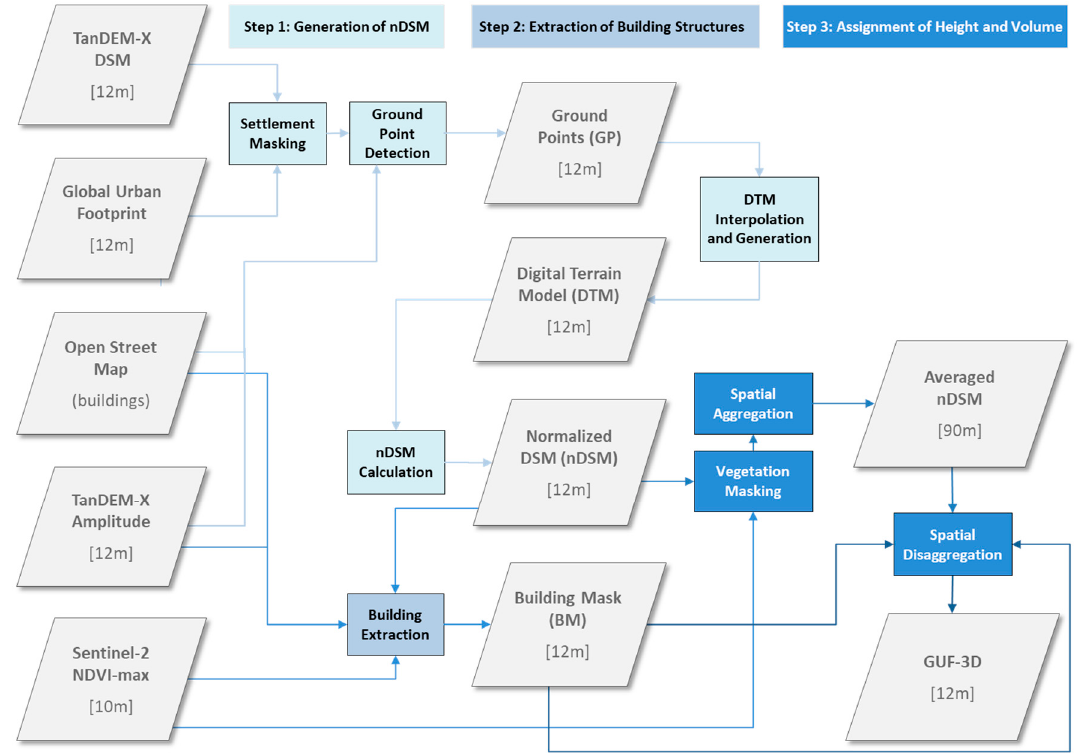
Figure 1. Schematic view of the Global Urban Footprint 3D (GUF-3D) production workflow.